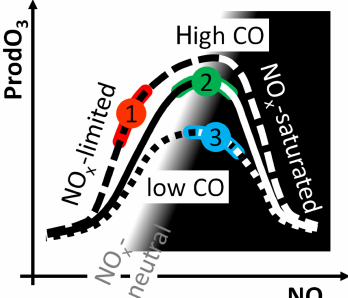
Figure 12. Schematic of the dependence of photochemical O 3 pro- duction (ProdO 3 ) on NO x and CO mixing ratios (after Grooß et al., 1998). Red, green and blue highlight photochemical conditions that are discussed in the text. Approximate numbers (Ehhalt and Rohrer, 1994; Jaeglé et al., 1998; Grooß et al., 1998) for UT condi- tions at northern midlatitudes the point of maximum O 3 production may vary between 200 and 700pmolmol − 1 NO x . The maximum net O 3 production varies by a factor of about 4, depending on am- bient